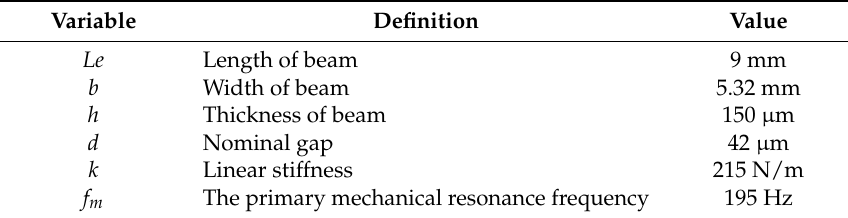
Figure 2. The microelectromechanical systems (MEMS) device electrical and mechanical model schematics. ( a ) A schematic for the MEMS equivalent circuit. The resonator is modeled as an imperfect capacitance with a small series (lead) inductance (L s ) and a variable capacitance (C MEMS ) reflecting the change in capacitance because of the motion, parallel parasitic capacitance (C p ), a negligible plate resistance (R plate ), and an almost infinite parallel dielectric resistance (R dielectric ). All components aside from C MEMS and C p are negligible in the model. ( b ) A simplified RLC circuit model for the MEMS circuit consisting of the resonator and the externally added resistance R and inductance L. ( c ) Single-degree-of-freedom mechanical model of the resonator. Table 1. Mechanical properties of the structure.